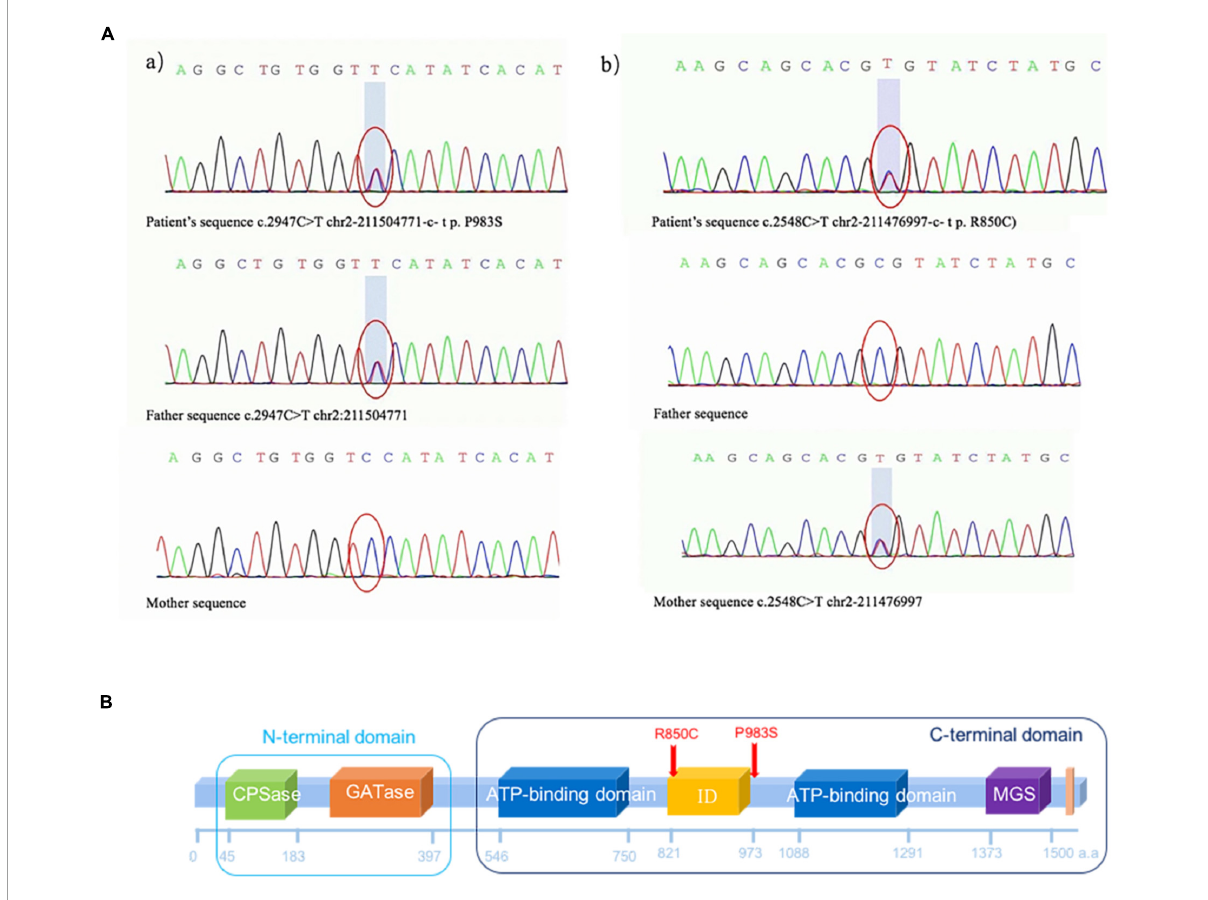
FIGURE3 (A) Missense variant identified in the CPS1 gene in the patient through exome sequencing. (a) Novel heterozygous missense variants c.2947C > T (p.P983S) in exon 24 and (b) c.2548C > T (p.R850C) in exon 20. (b) Sanger sequencing revealed that the father had a